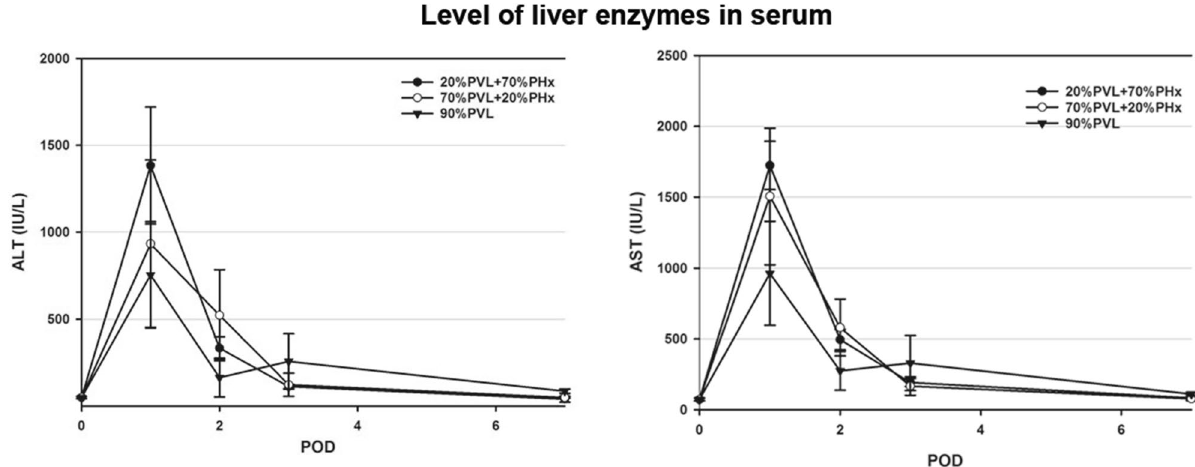
Figure 1. Serum level of ALT and AST from serum sample after simultaneous PVL + PHx and PVL alone. To evaluate the surgical stress and liver injury, the level of serum ALT and AST was measured. The serum ALT and AST were increased rapidly after simultaneous PVL + PHx and PVL alone and decreased to normal level within 7 days. No significant difference was observed between simultaneous PVL + PHx and PVL alone.